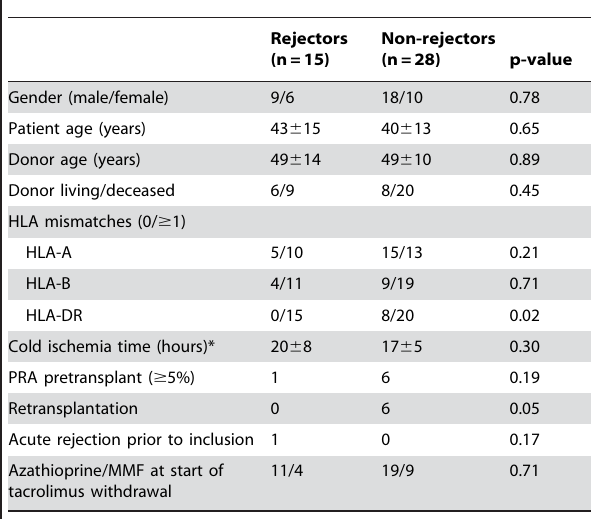
Table 1. Patient